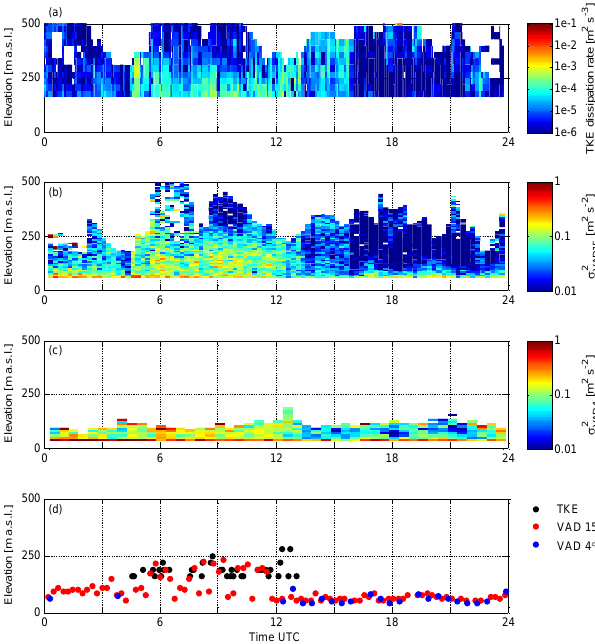
Figure 4. Diurnal variation at Limassol on 24 August 2013 of (a) TKE dissipation rate, (b) σ 2 from 30 ◦ elevation angle VAD, (c) VAD σ 2 from 10 ◦ elevation angle VAD and (d) MLH. VAD